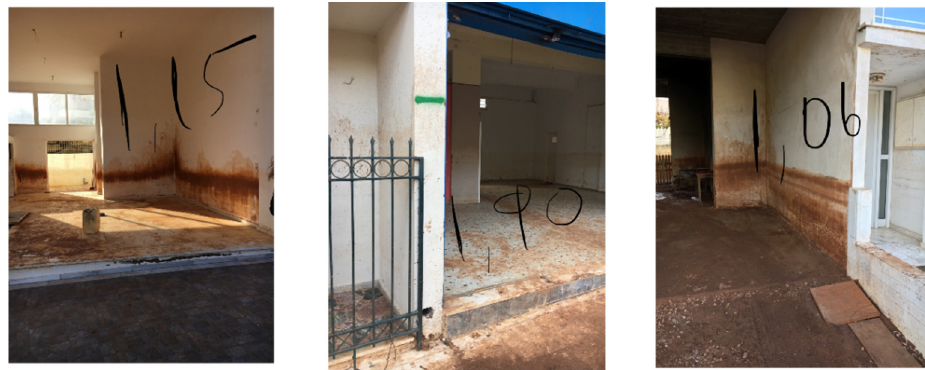
Figure 4. Indicative observation points in Mandra town (in roads): the observed maximum depths are 0.64 m (up & left), 1.01 m (up & right), 0.54 m (down & left), 1.70 (down & right).